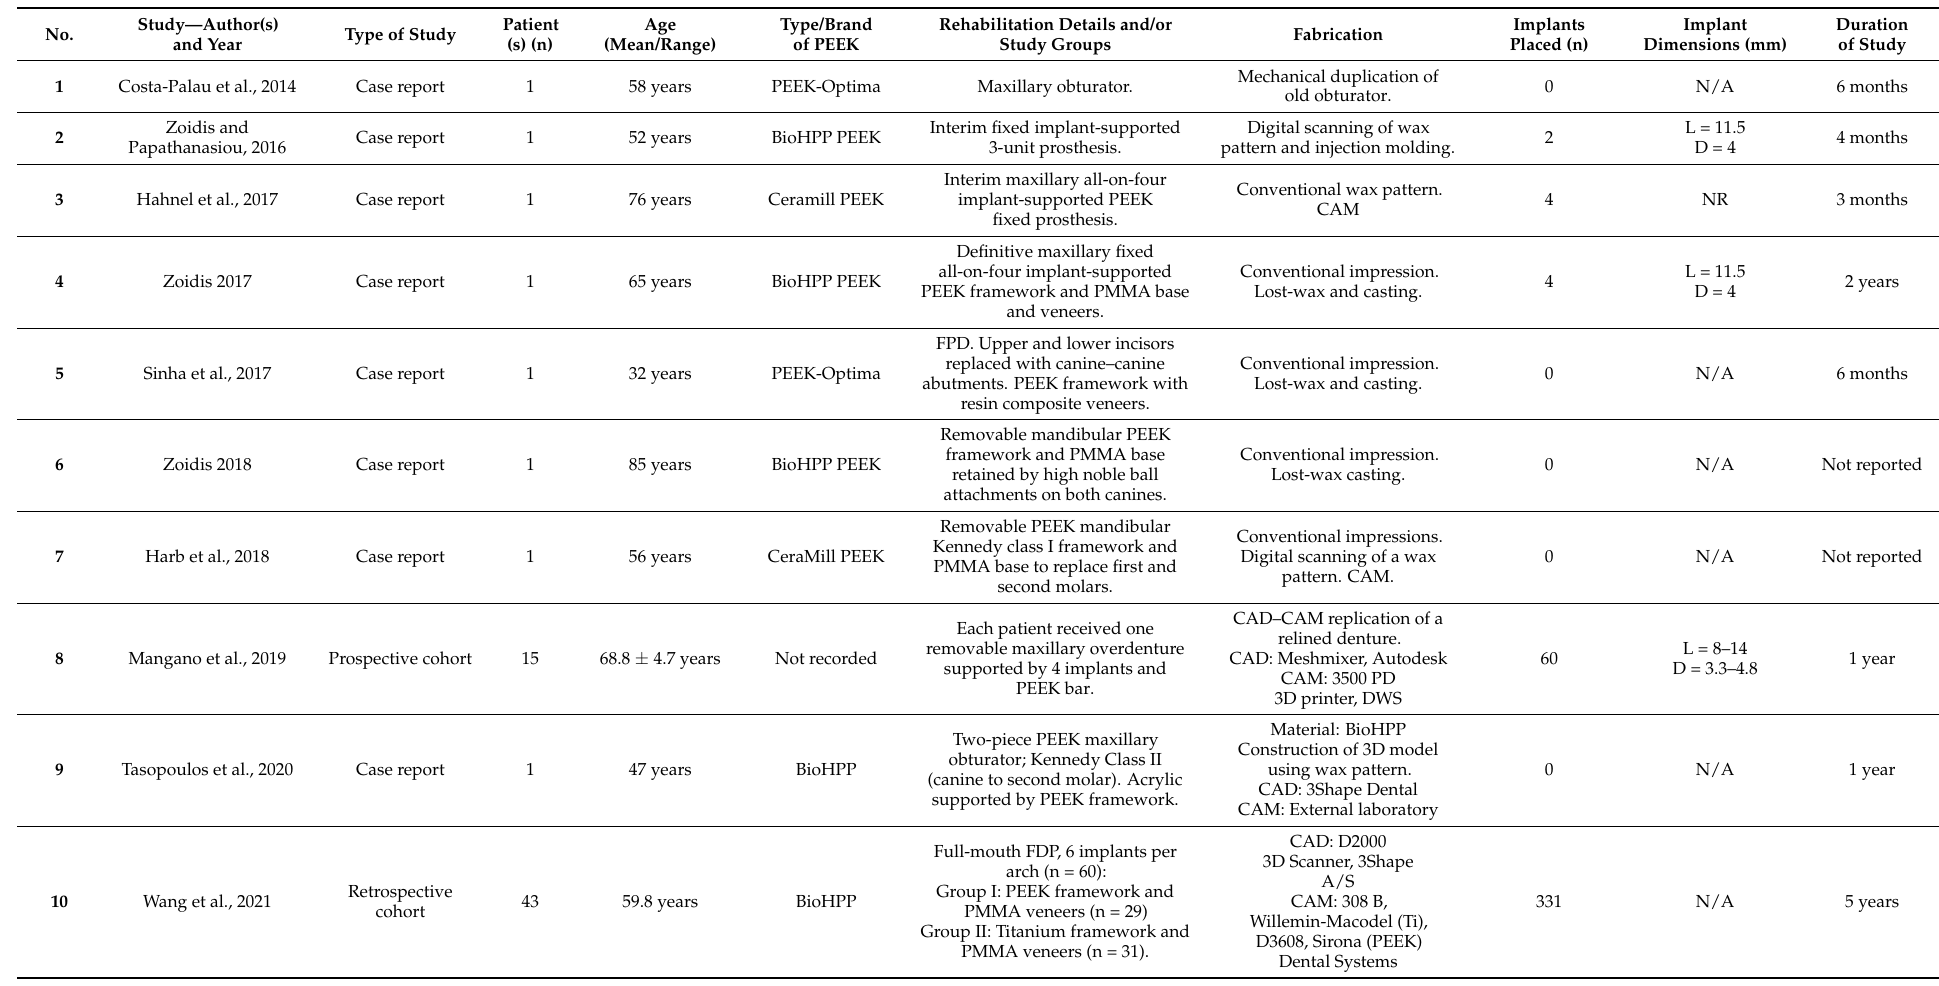
Table 2. General characteristics of studies included in this review. PEEK: polyetheretherketone; N/A: not application; CAD: computer-aided design; CAM: computer-aided